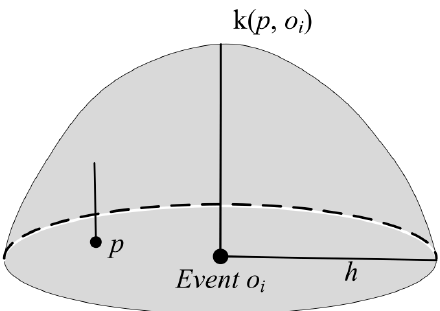
Figure 2. Standard kernel function for density estimation.